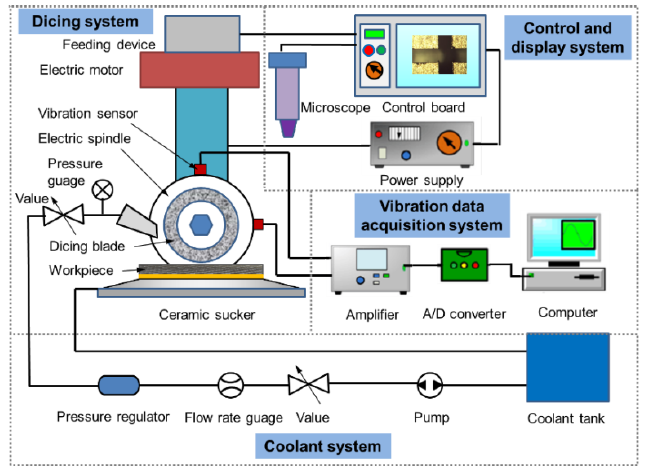
Figure 2. Schematic diagram of dicing system for CFRP composites.